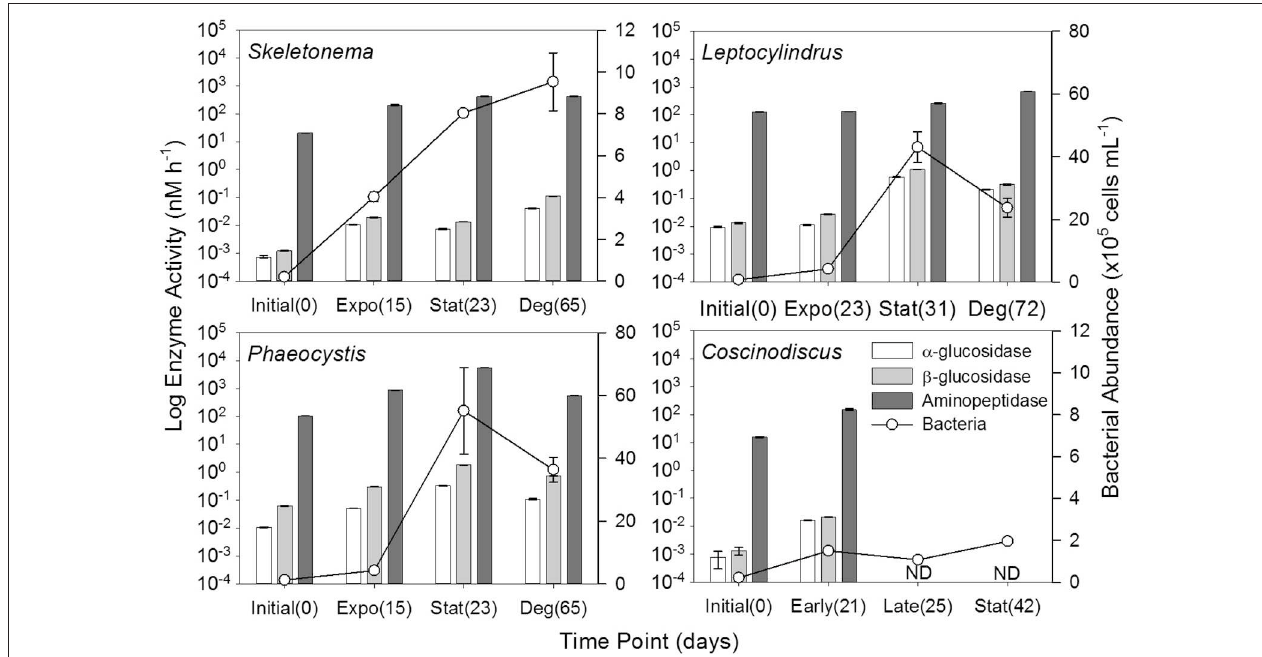
FIGURE 8 | Hydrolytic enzyme activities ( α -glucosidase, β -glucosidase, and aminopeptidase) and bacterial abundance for genera Skeletonema ( n = 3), Leptocylindrus ( n = 2–4), Phaeocystis ( n = 3), and Coscinodiscus ( n = 3–4). Samples were collected at initial, exponential (Expo), stationary (Stat), and after 6 weeks of degradation (Deg), except for Coscinodiscus sp. which had time points collected at initial and early exponential (Early); no enzyme activity data (ND) were available for late exponential (Late) and stationary. The number of days following inoculation are given in parentheses. All data are presented as mean ± standard error.